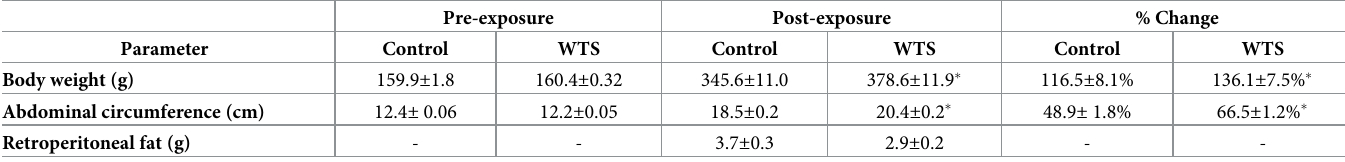
Table 1. Effect of WTS on body weight, abdominal circumference and retroperitoneal fat.